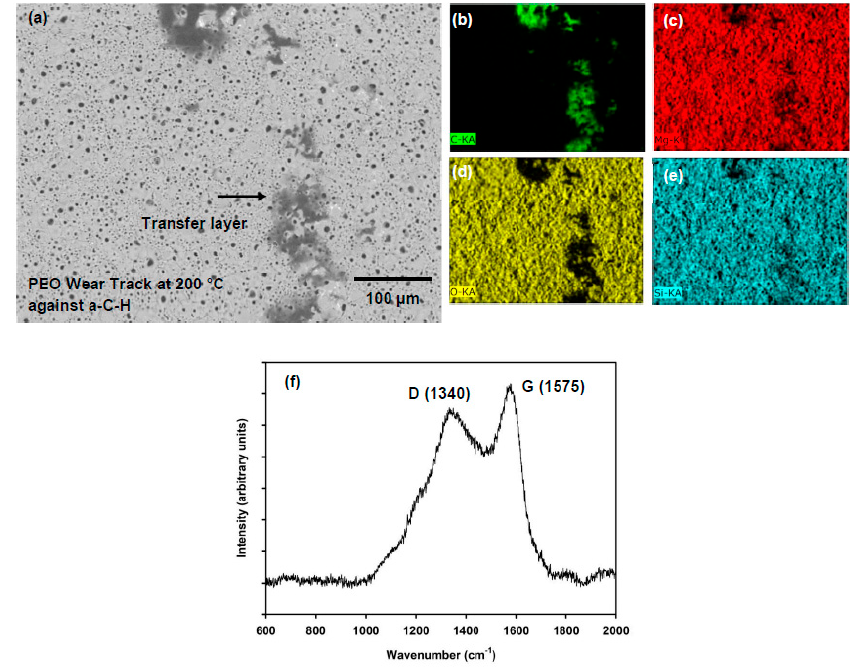
Figure 6. ( a ) SEM image (back scattered mode) of the wear track formed on PEO-coated AZ31 when running against a-C-H at 200 ° C; EDS spectrum of the carbonaceous materials transfer from the a-C-H counterface revealing ( b ) C, ( c ) Mg, ( d ) O and ( e ) Si; The transfer layer shown by arrows; ( f ) Raman signal of the carbonaceous transfer layer confirming that a-C-H coatings were graphitized during sliding.